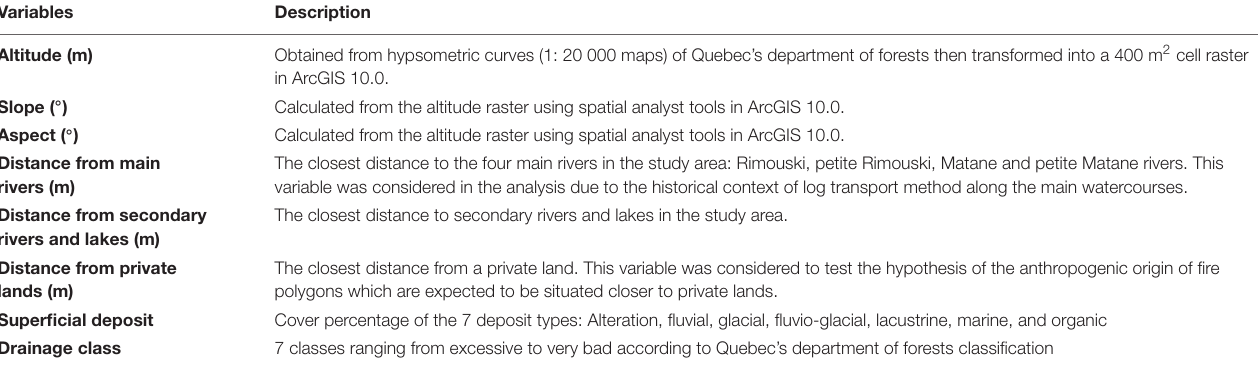
TABLE 2 | Environmental variables used in the RDA analysis.